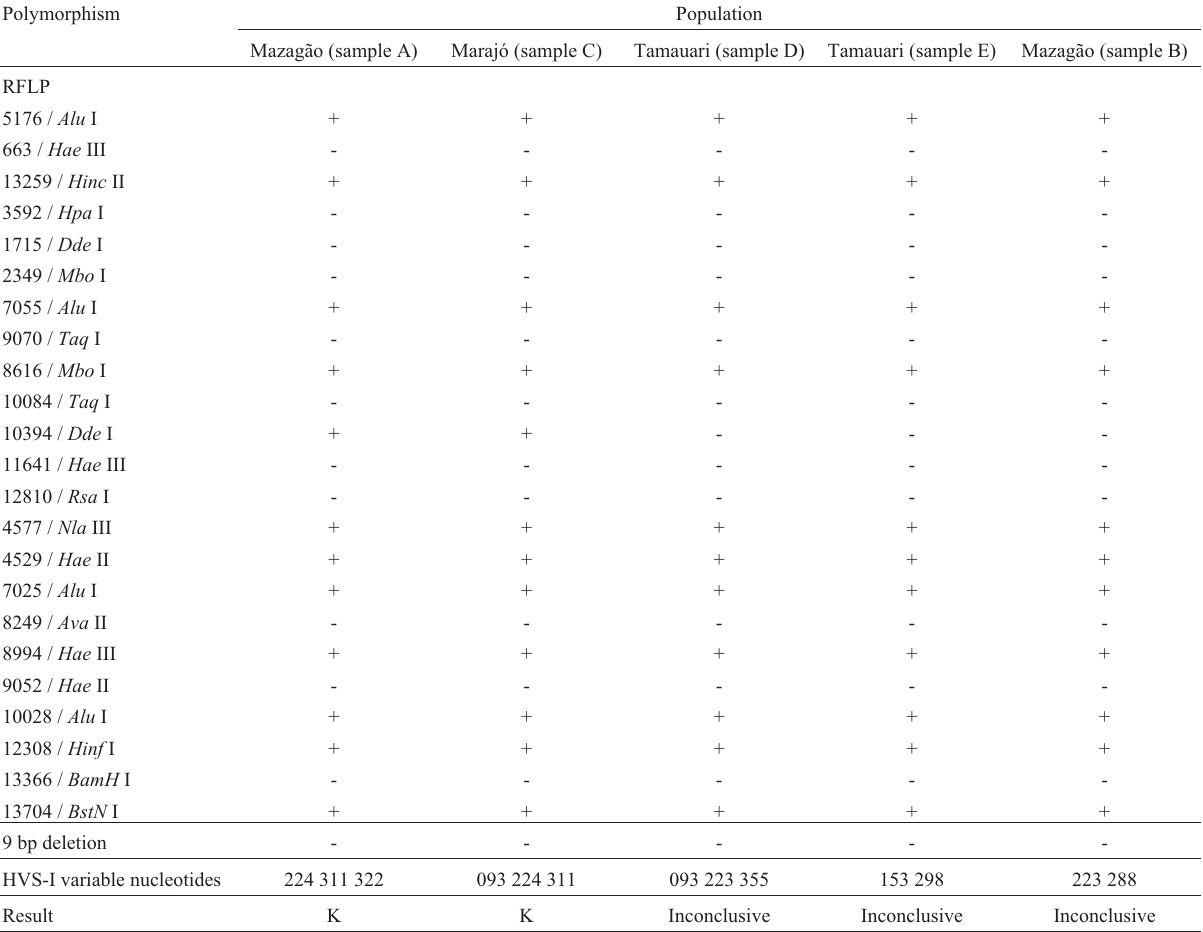
Table 4 - Haplogroup classification on five individuals from the Brazilian Amazon Afro-descendant communities of Mazagão (denominated as samples “A” and “B”), Marajó (denominated as sample “C”) and Tamauari (denominated as samples “D” and “E”). The classification was based on screening for 23 restriction fragment length polymorphisms (RFLP) and the 9 bp deletion plus the sequencing of the first hypervariable region (HVS-I). For the exact nucleotide position of the HSVI 16000 should bee added to the value for each group.